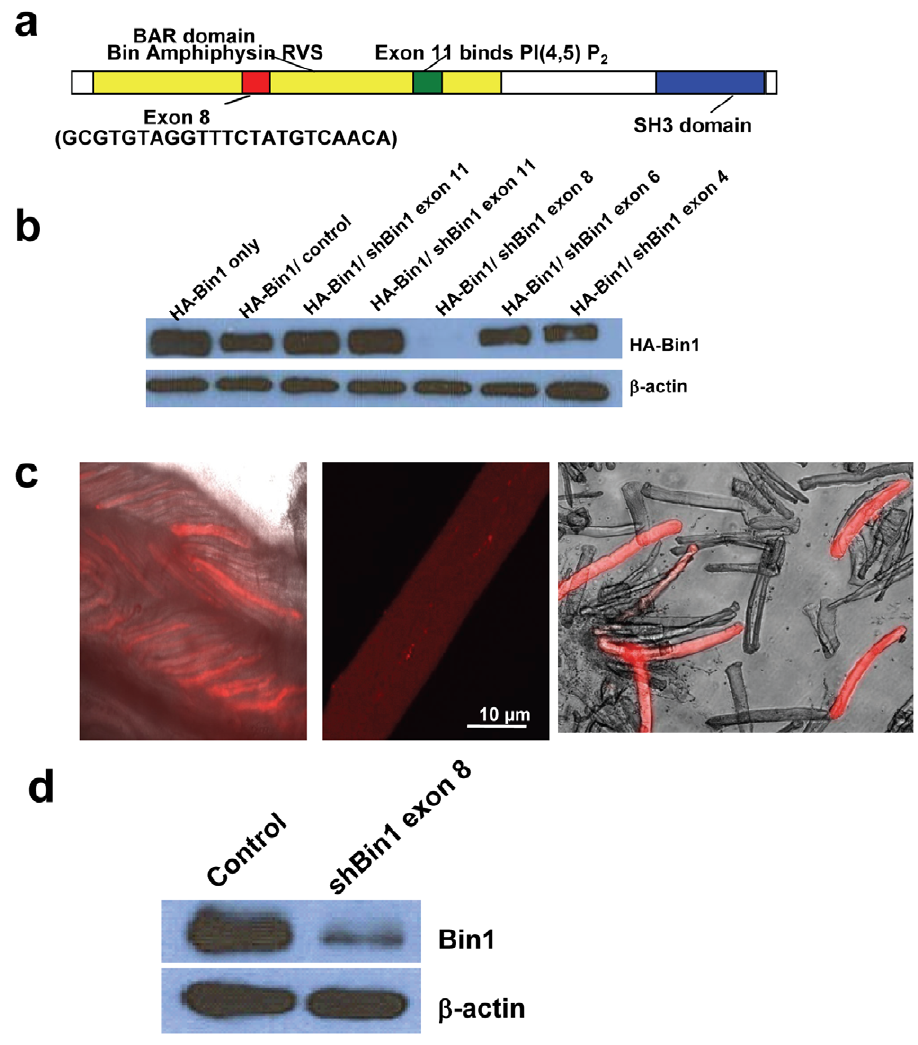
Figure 1. shRNA-mediated knockdown of Bin1 in adult skeletal muscle. (a) Protein domains of Bin1. The listed nucleotide sequence in exon 8 represents the shRNA against Bin1 (b) Western blots of whole cell extracts from HEK293 co-transfected with a murine Bin1 cDNA plasmid and various shRNA constructs against Bin1. This assay allowed screening for the most effective shRNA at knocking down Bin1 expression. (c) High efficiency gene delivery at 14 days-post electroporation was achieved as shown by the high expression of RFP signals on the flexor digitorum brevis (FDB) muscle bundles that were electroporated with either shRNA-Bin1 or shRNA-control plasmid ( left ). RFP signal was used to identify individually transfected single muscle fiber (middle , right ). (d) Western blot was performed on the trimmed FDB muscle bundle that was transfected with either shRNA-control or shRNA Bin1 to confirm the potency of shRNA-Bin1 in knocking down endogenous Bin1 expression in adult skeletal muscle (n=4 mice).